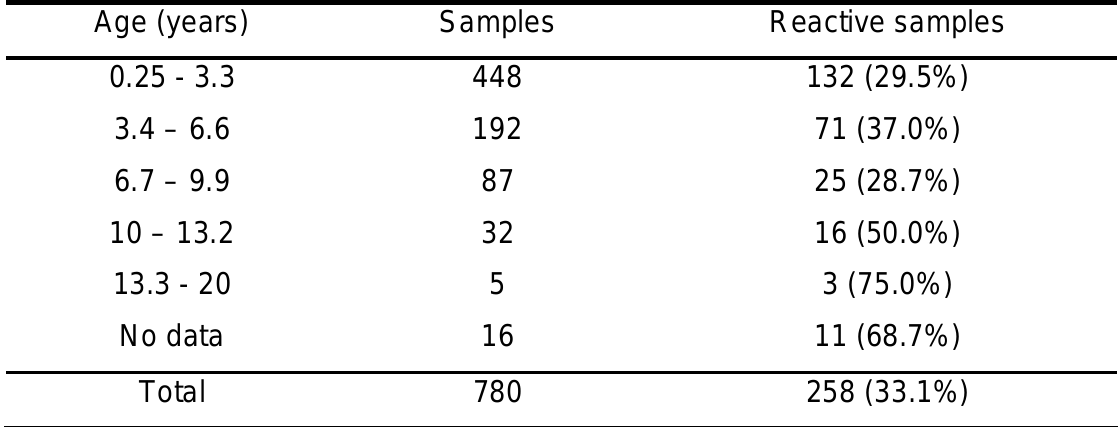
Table 1. Occurrence of anti- Toxoplasma gondii antibodies confirmed by indirect fluorescent antibody test in dogs from Botucatu, São Paulo State, Brazil, according to age, in